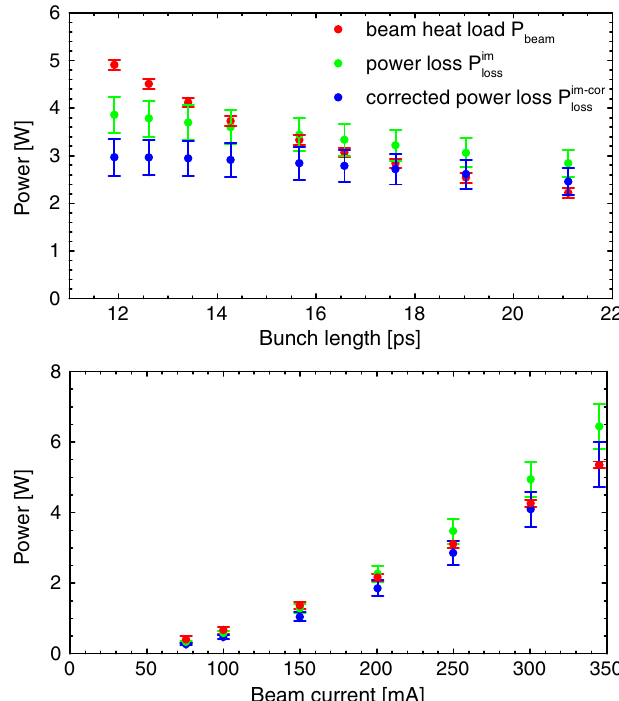
FIG. 17. Comparison between the power losses due to the impedance up to 10 GHz in Fig. 15 and measured beam heat load for 250 mA beam current and 900 bunches with different bunch lengths (top) and a beam current ramp with 900 bunches (bottom). The blue points are corrected by the difference between normal and anomalous skin effect ( RRR ¼ 200